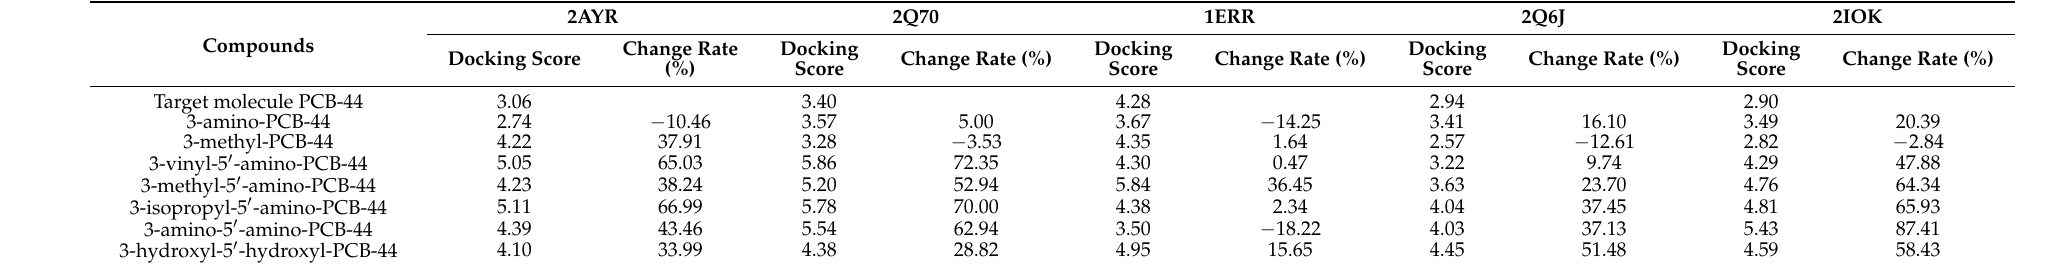
Table 4. Docking scores of 7 types of novel PCBs molecules bound to different types of hER α